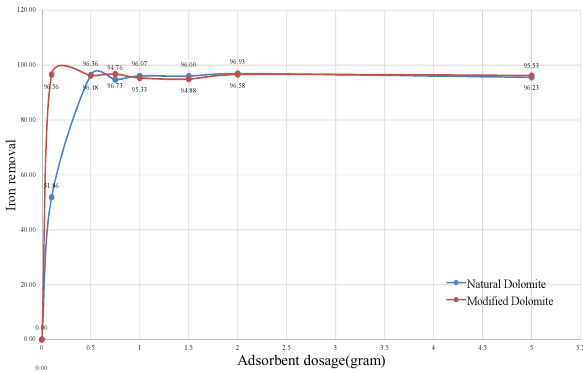
Fig. 10. Comparison of removal rate of iron from natural dolomite (5 mg/l) and modified dolomite with contact time of 60 minutes in specified